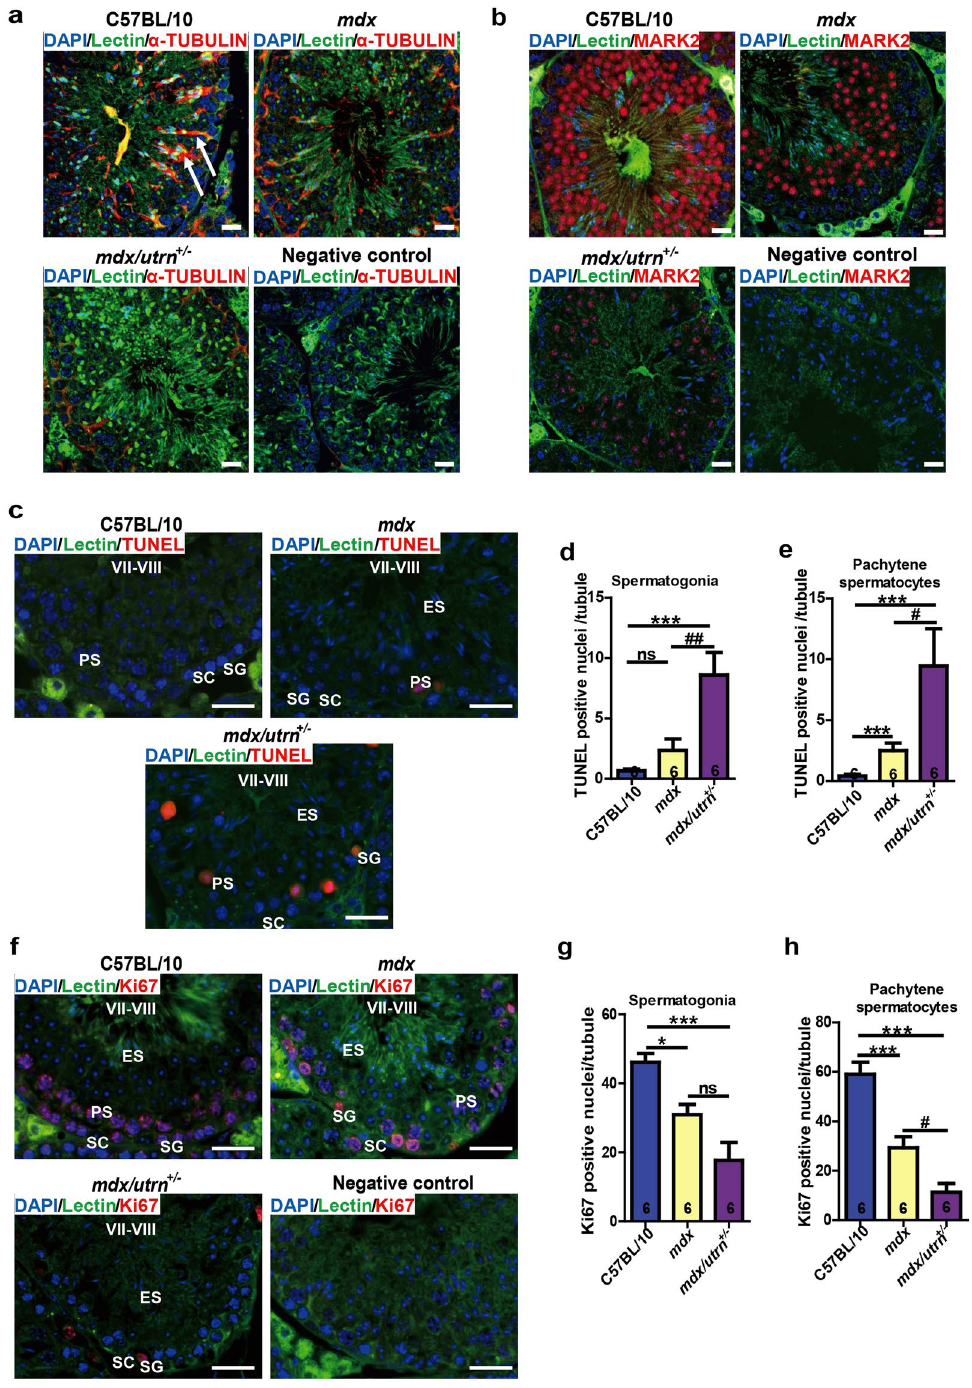
Figure 7. Utrophin haplodeficiency aggravates apoptosis raise and proliferation reduction of dystrophin- deficiency mouse spermatogenic cells. ( a ) The microtubule protrusion of the Sertoli cells in C57BL/10, mdx and mdx/utrn + / − testes. ( b ) MARK2 positive cells in C57BL/10, mdx and mdx/utrn + / − testes. ( c ) Cross-sections of ten-week-old mouse testes were labeled with TUNEL to identify the apoptotic cells. ( d ) The number of TUNEL- positive spermatogonia per seminiferous tubule in C57BL/10, mdx and mdx/utrn + / − testes. ( e ) The number of TUNEL-positive pachytene spermatocytes per seminiferous tubule in C57BL/10, mdx and mdx/utrn + / − testes. ( f ) Proliferating cells were labeled with Ki67 in the cross-sections of ten-week-old mouse testes. ( g ) The number of the Ki67-positive spermatogonia per seminiferous tubule in C57BL/10, mdx and mdx/utrn + / − testes. ( h ) The number of Ki67-positive pachytene spermatocytes per seminiferous tubule in C57BL/10, mdx and mdx/utrn + / − testes. MARK2: microtubule affinity regulating kinase 2; ns: not significant. Data were analyzed with one-way ANOVA, n = 6. All values are represented as mean ± SEM. * compared with the C57BL/10; # compared with the mdx . # P < 0.05; ## P < 0.01; * P < 0.05; *** P < 0.001. Scale bar: 50 μ